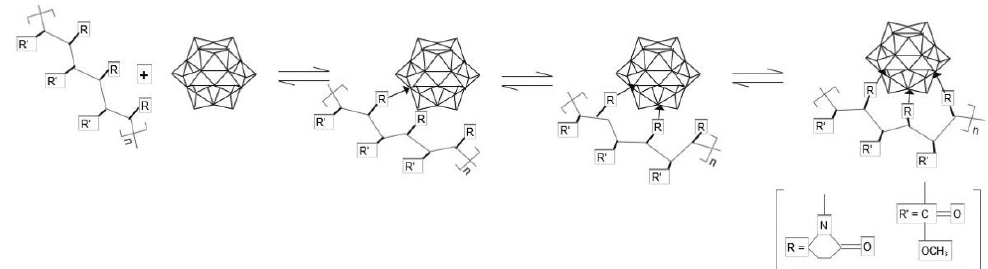
Figure 9: Schematic shows interfacial interactions between PWA particles and organic matrix during the composite